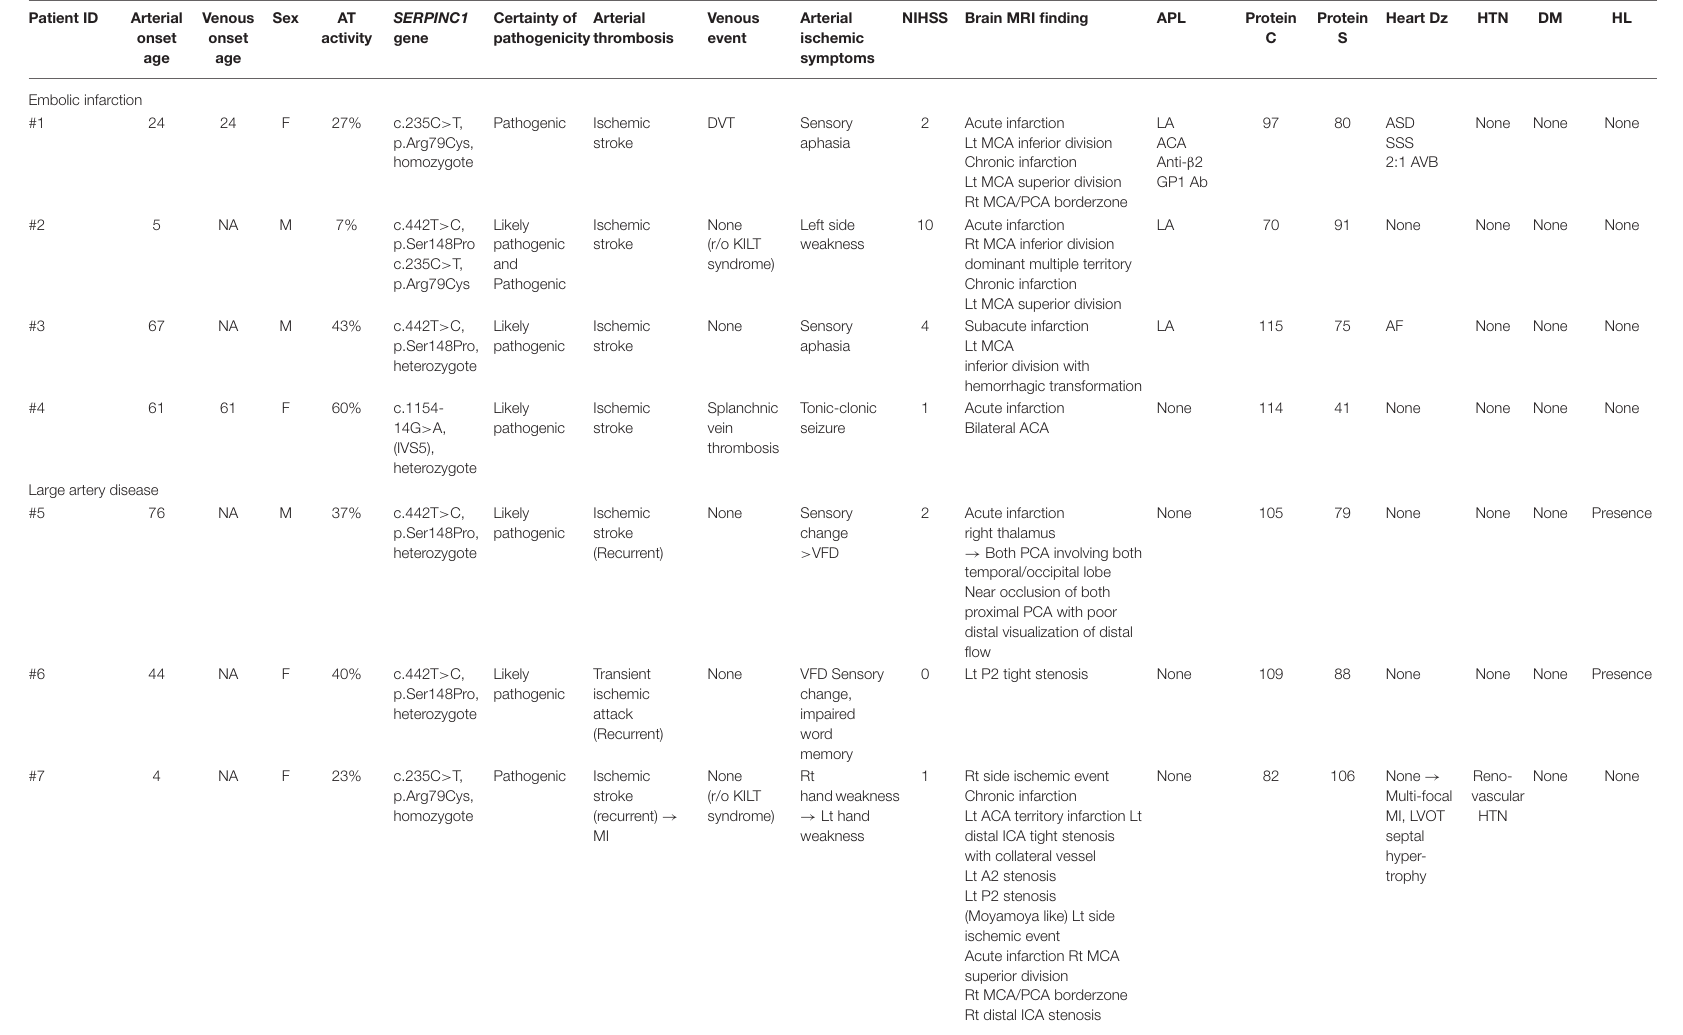
TABLE 2 | Detailed Profile of the Ischemic Stroke patients with SERINC1 variants. Patient